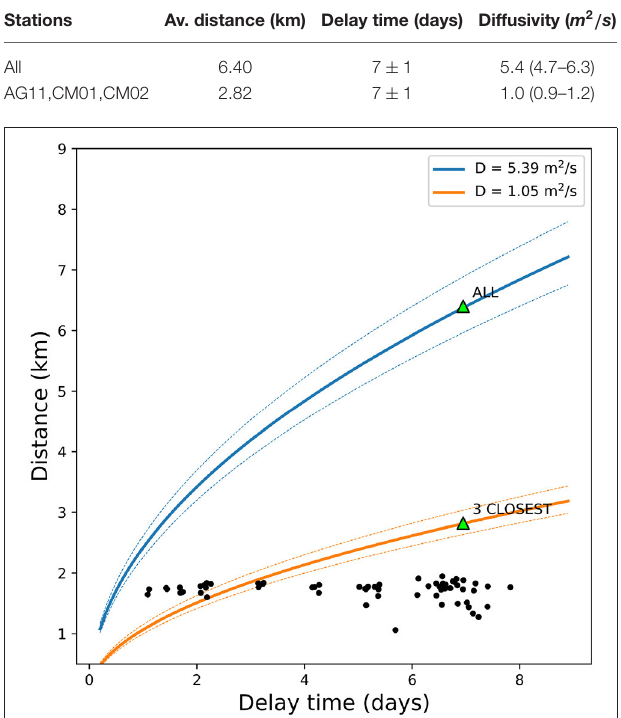
TABLE 1 | Average inter-station distance, observed peak delay time and diffusivity computed from Improta et al. (2017). Stations